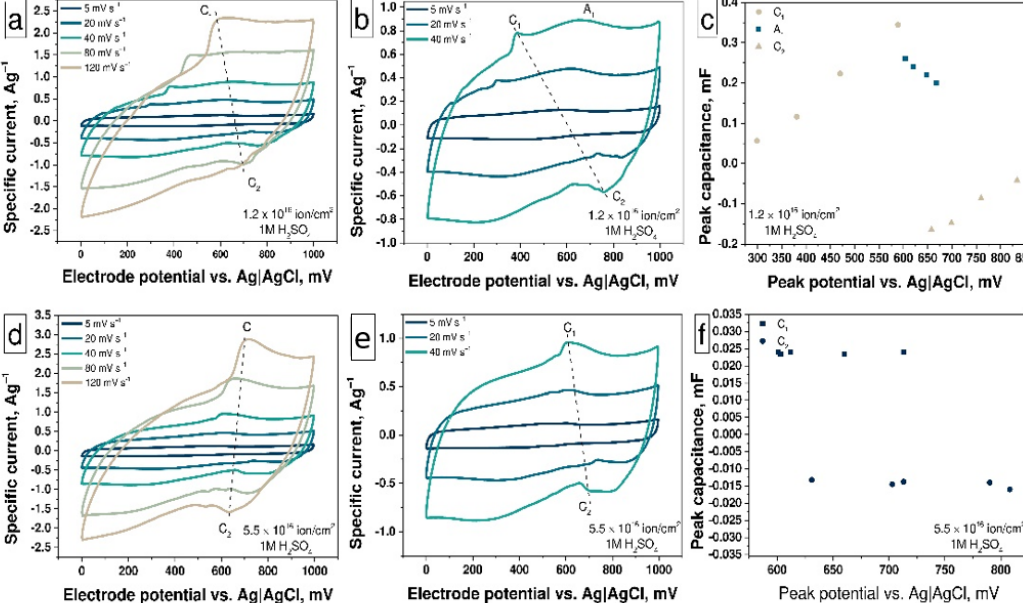
Figure 6. The CV curves at the scan rates in the range from 5 to 120 mV · s − 1 ( a , d ) and from 5 to 40 mV · s − 1 ( b , e ); the peak capacitance vs. peak potentials plot ( c , f ) for N-MWCNTs irradiated by ion beam with different